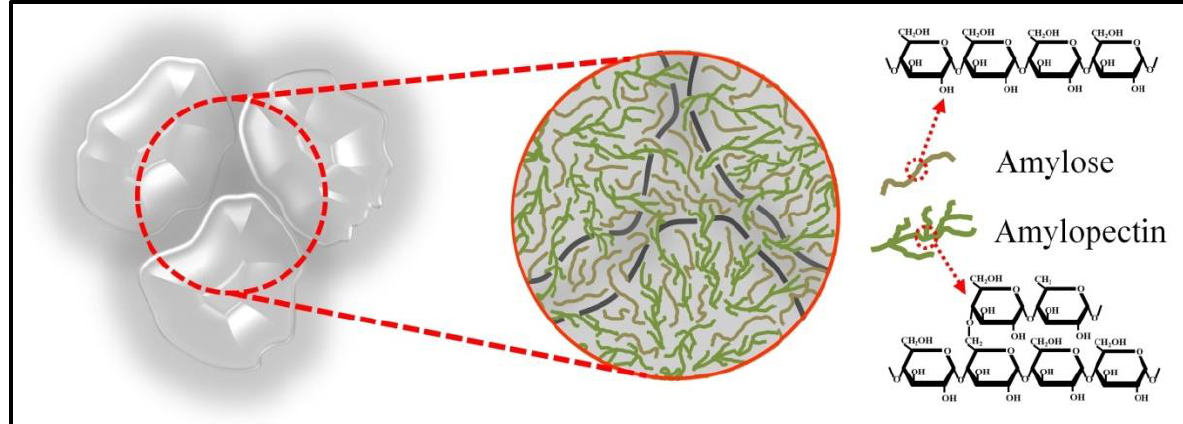
Figure 6. Schematic representation of the recrystallized starch chain distribution. As seen in Figure 5, the ε (cid:48)(cid:48) of the native and modified forms of the starches exhibits two peaks, at 0.5 GHz and 4.5 GHz. It can be observed that ε (cid:48) exhibits a major decline from 5 MHz-1 GHz and a minor decline from 4–5 GHz (Figure 4). The relaxation peak implies the rotations of the permanent dipoles that fail to react synchronously with the oscillation of the applied field as the frequency exceeds the relaxation frequency of the starches, resulting in a higher dissipation of energy and the presence of the maximum peak of ε (cid:48)(cid:48) . This might be mainly due to the presence of the hydroxyl side groups (–OH) and hydroxymethyl side group (–CH 2 OH) of the starches, which carry permanent dipole moments [2,9,22]. The loss factor reduction is relatively larger (71.42%) for the modified-Rs when compared with the other samples in the frequency range of 5 MHz–5 GHz. In